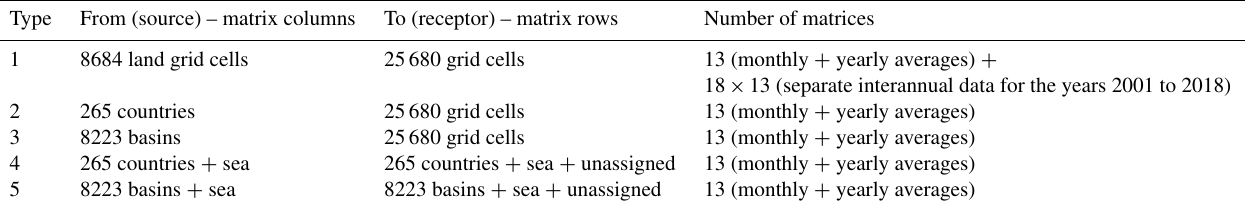
Table 2. Source–receptor matrices of the created dataset (type 1: land grid cell to grid cell; type 2: country to grid cell; type 3: basin to grid cell; type 4: country to country; type 5: basin to